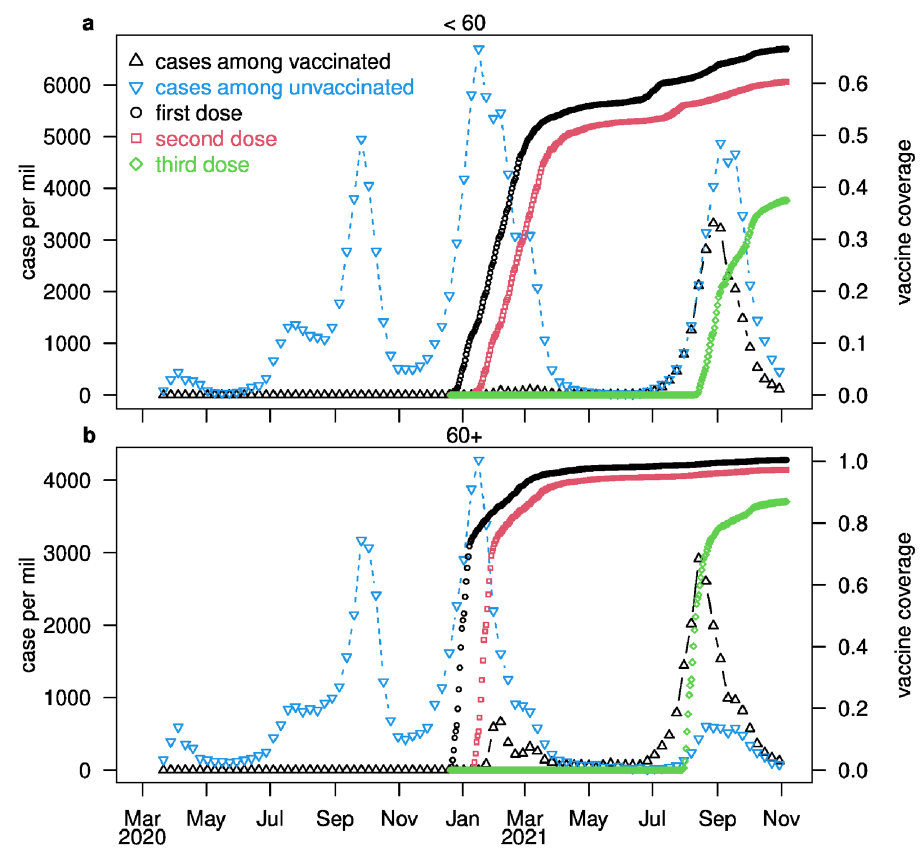
Fig 3. Infection and vaccination dynamics in Israel. Weekly reported COVID-19 cases are presented for the < 60 age group in (a) and for the 60+ age group (b) (population standardized, per 1 million individuals in an age group) in unvaccinated (blue, down-facing triangles) and fully vaccinated (black, up-facing triangles) individuals. The cumulative vaccine coverage for the first, second and third dose are represented by black circles, red squares, and green diamonds.